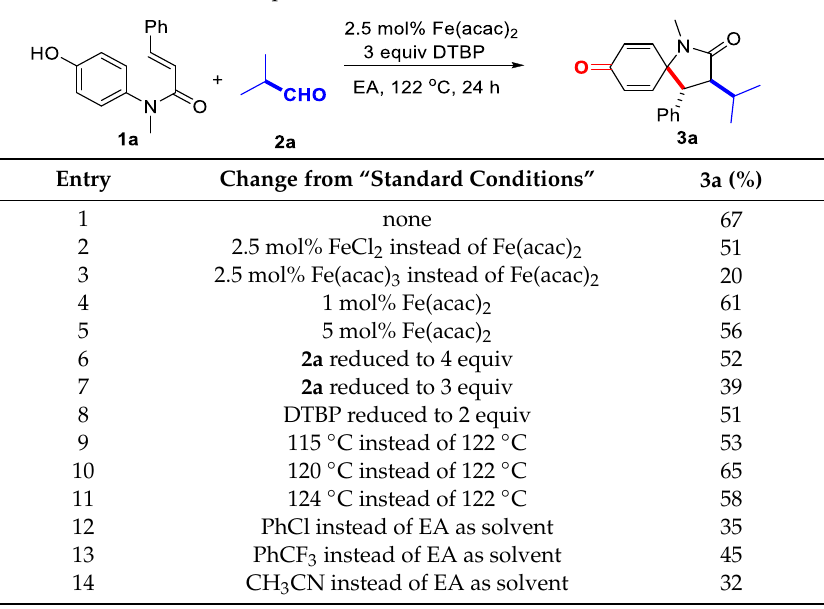
Table 1. Optimization of reaction conditions a .